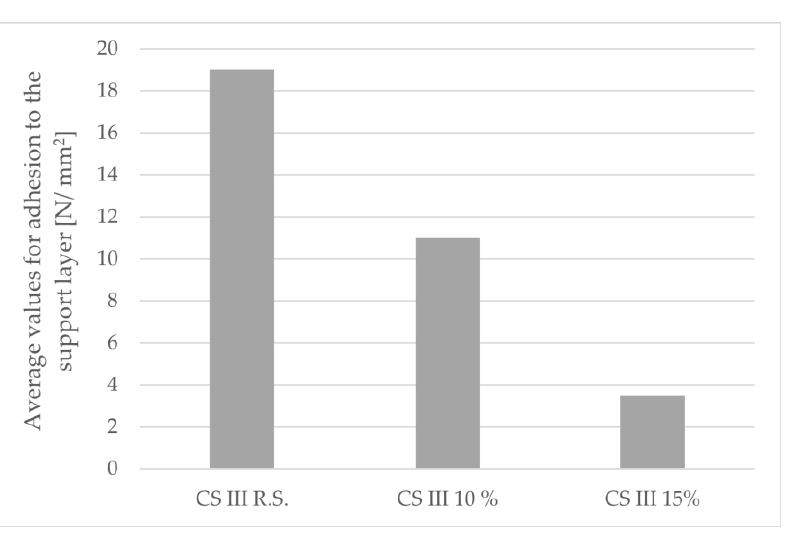
Figure 17. Results obtained for adhesion to the support layer.